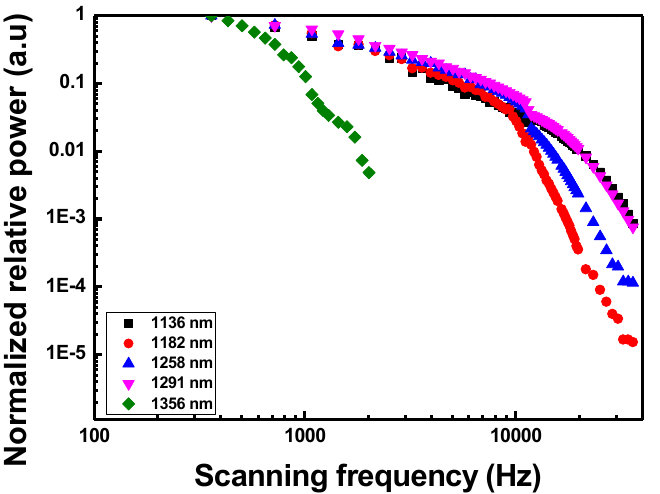
Figure 11. Relative intensity variations of each wavelength component as a function of scanning frequency .